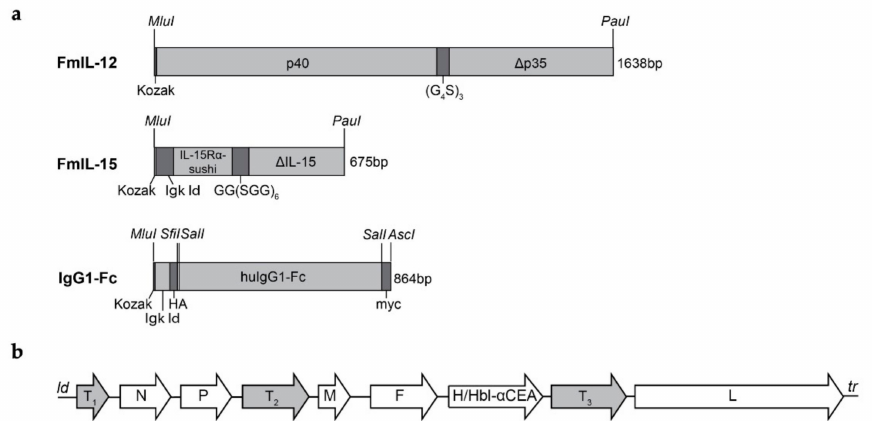
Figure 1. Cloning of oncolytic measles vaccines encoding FmIL-12 or FmIL-15. ( a ) Design of the FmIL-12, FmIL-15, and IgG1-Fc expression cassettes. The FmIL-12 cassette consists of the mIL-12 p40 and p35 subunits separated by a (G 4 S) 3 linker preceded by a Kozak sequence. The signal